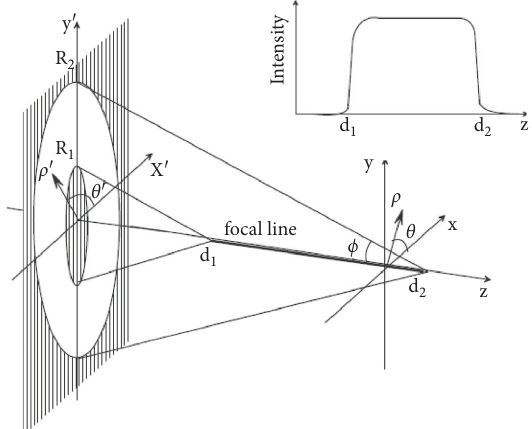
Figure 1: Geometry of the annular-aperture diffractive axicon and a notation of the corresponding on-axis profile of image intensity (Figure from [18]).